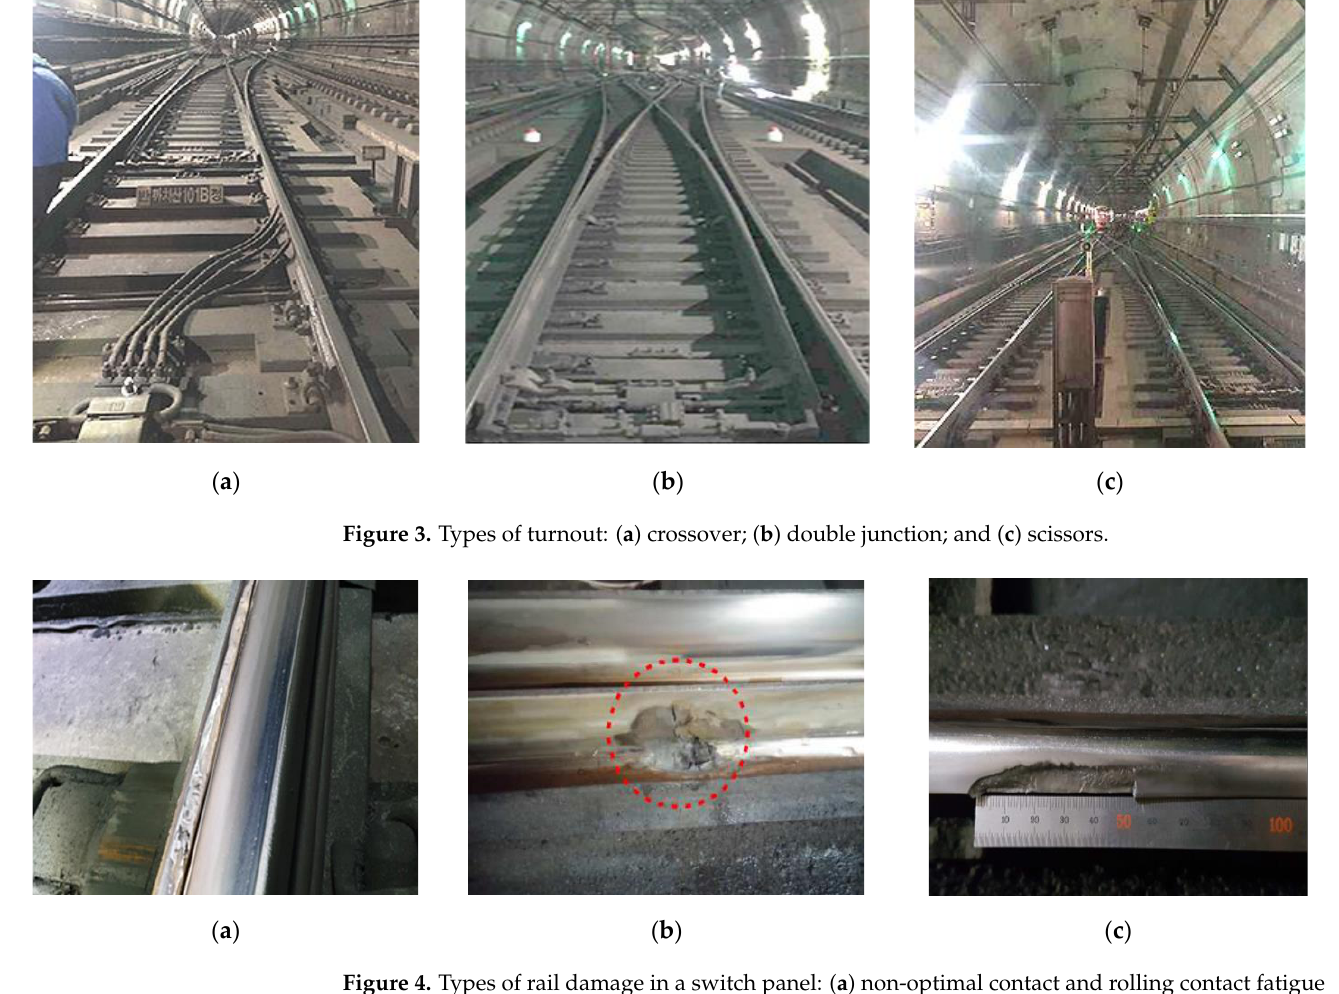
Figure 3. Types of turnout: ( a ) crossover; ( b ) double junction; and ( c ) scissors.